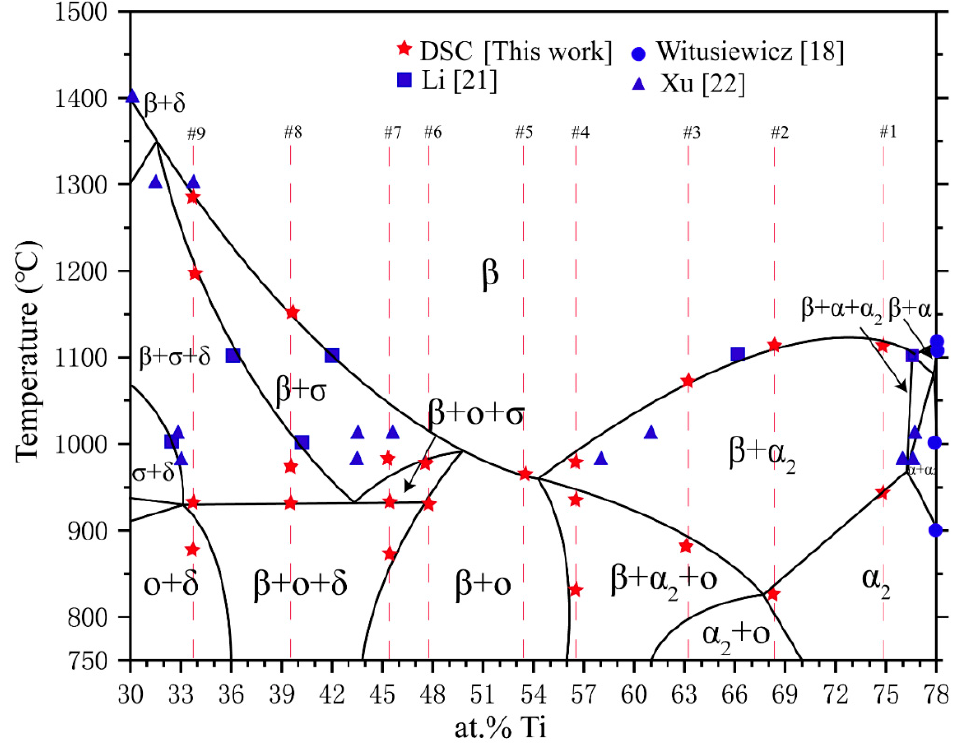
Figure 7. Overview of the polythermal section of the Ti-Al-Nb ternary system using data from this work and from [18,21,22] .